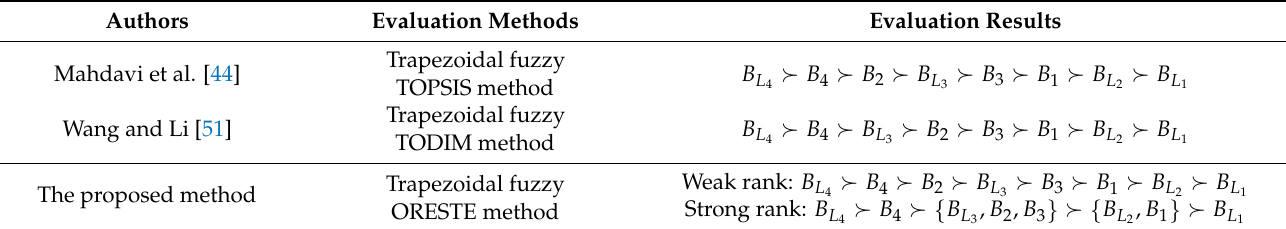
Table 12. Evaluation results of other MCDM